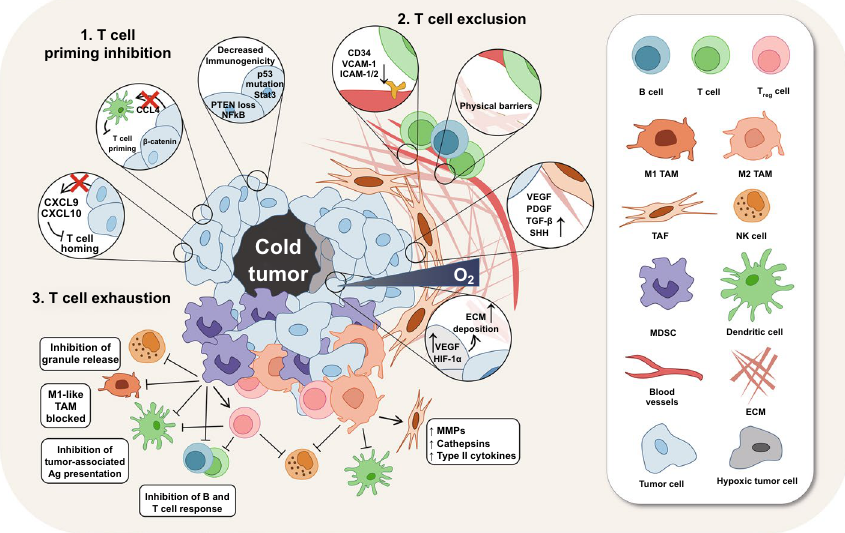
Fig. 1 Immunosuppressive mechanisms of the tumor immune microenvironment in cold tumors. STAT3, signal transducers and activators of transduction-3; NF-κB, nuclear factor kappa-B; CCL4, CC-chemokine ligand 4; CXCL9/CXCL10, CXC-chemokine ligand 9/10; VCAM-1, vascular cell adhesion molecule 1; ICAM-1/2, intercellular adhesion molecule-1/2; VEGF, vascular endothelial growth factor; PDGF, platelet- derived growth factor; TGF-β, transforming growth factor-β; SHH, sonic hedgehog; ECM, extracellular matrix; HIF-1α, hypoxia-inducible fac- tor 1α; TAM, tumor-associated macrophages; MMPs, matrix metalloproteinases; TAF, tumor-associated fibroblast; NK cell, natural killer cell; MDSCs, myeloid- derived suppressor